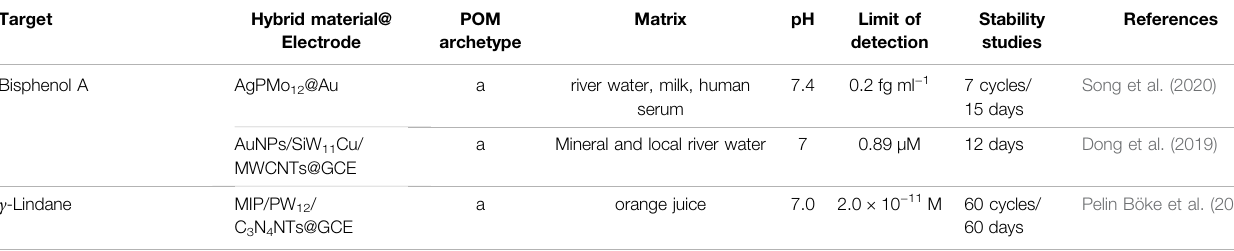
Abbreviations as reported by the authors. 2D-hBN, two dimensional hexagonal boron nitride nanosheets; β -CD, ß -cyclodextrin; AgNPs, silver nanoparticles; Au, gold electrode; AuNPs, gold nanoparticles; C 3 N 4 NTs, carbon nitride nanotubes; GCE, glassy carbon electrode; GO, graphene oxide; ITO, indium tin oxide electrode; MacroPC, macroporous carbon; MIP, molecularly imprinted polymer; MWCNTs, multi-walled carbon nanotubes; N-CNTs, nitrogen-doped carbon nanotubes; NR, not reported; OMC, ordered mesoporous carbon; PdNPs, palladium nanoparticles; PGE, pencil graphite electrode; PNC, preyssler nanocapsules; PPy, polypyrrole; PtNPs, platinum nanoparticles; rGO, reduced graphene